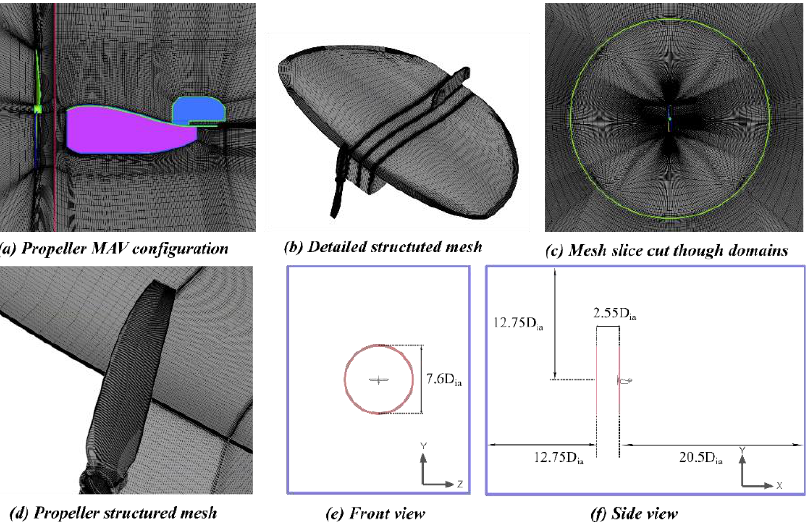
Figure 1. Non-conformal mesh interface for propeller MAV geometry, ( a ) propeller-MAV configuration, ( b ) detailed structured mesh for propeller-MAV, ( c ) Mesh slice cut though domains, ( d ) propeller structured mesh, ( e ) computational domain in front view, and ( f ) computational domain in side